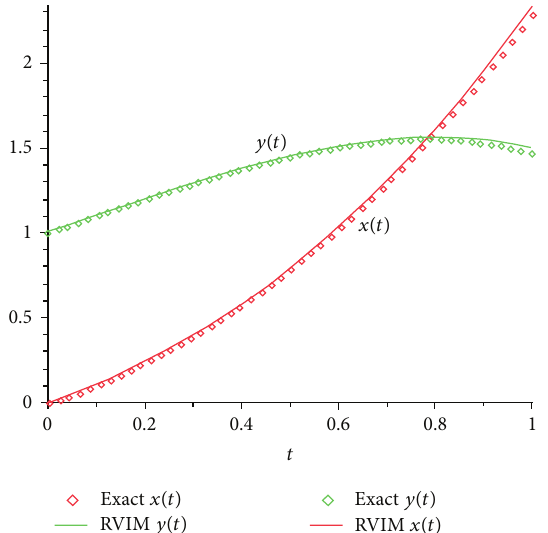
Figure 1: Comparison plot of RVIM method for system (17), when 𝛽 = 𝛾 = 1 with its exact solution.